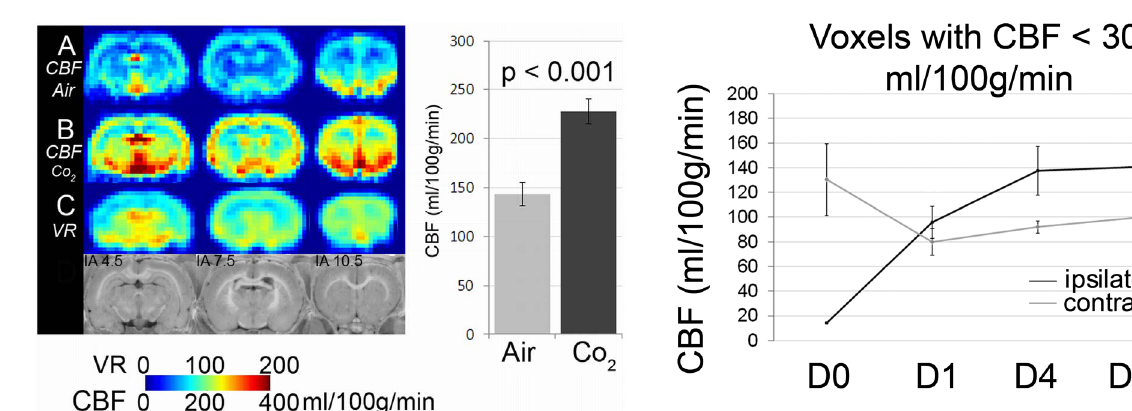
Figure 2. CBF in ischemic voxels over time. Black line: CBF changes within voxels with intra-ischemic CBF of , 30 ml/100 g/min between d 0 (D0; during vascular occlusion) up to d14 after MCAO. Grey line: contralateral CBF values from the same animals. Mean 6 SD values are shown. The GLM analysis for repeated measures demonstrated a significant effect of the within-subject factor ‘‘time’’ (p=0.03), but not of the between-subject factor ipsi- or contralateral side (p=0.7), but for the interception of the two factors (p , 0.0001).